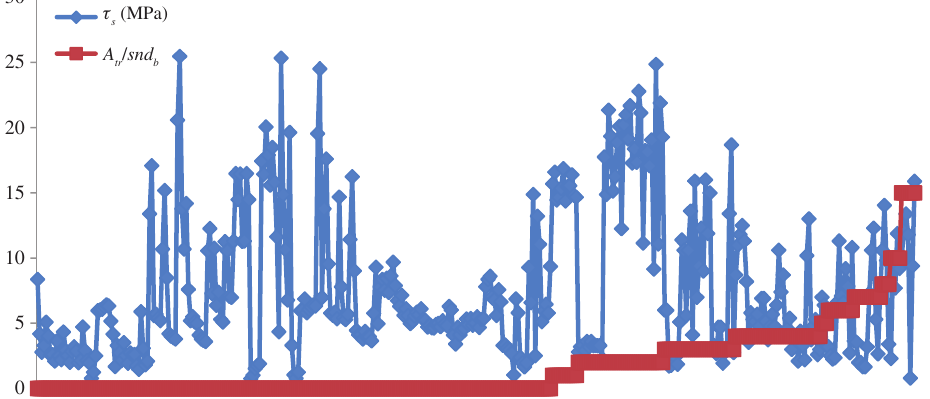
Figure 23: Change in the bond strength of FRP bars in concrete with changing transverse reinforcement